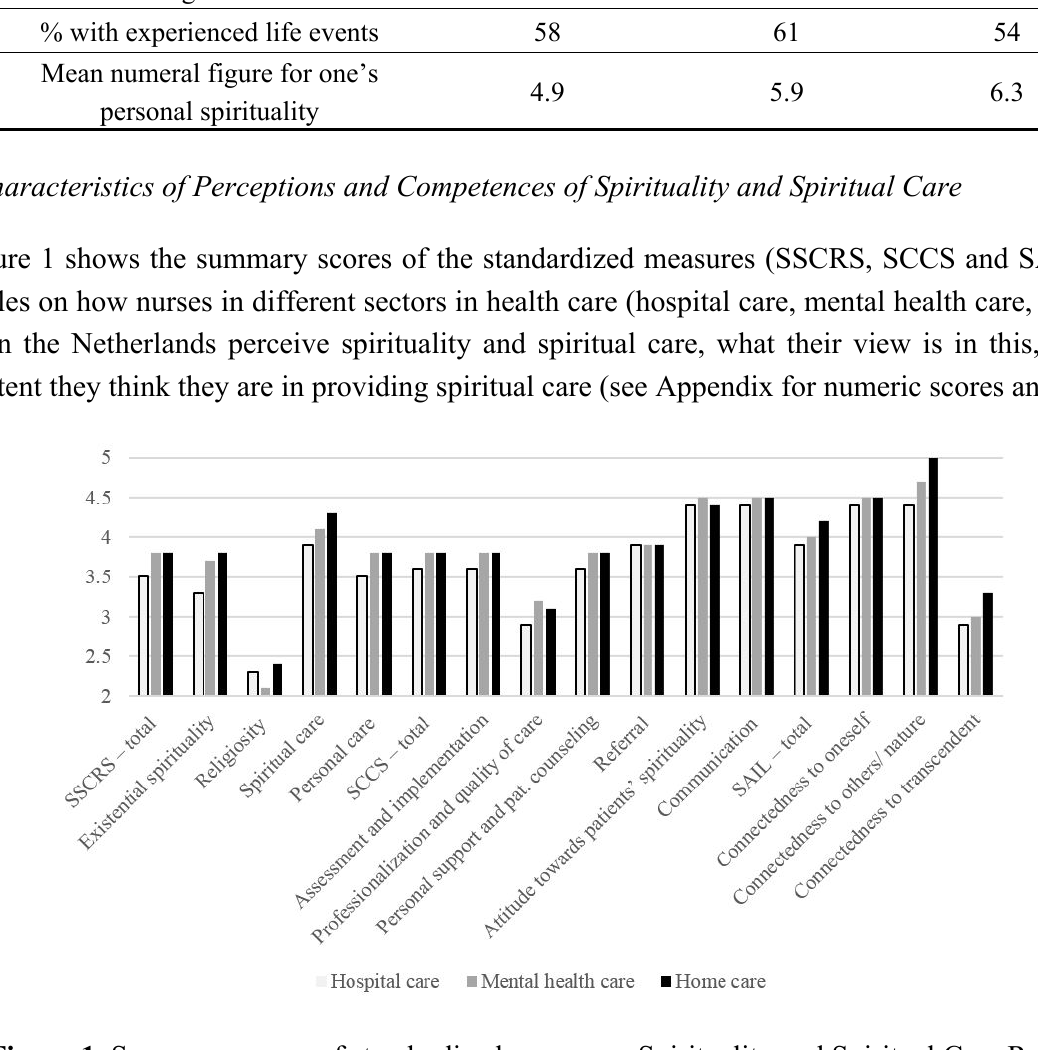
Figure 1. Summary scores of standardized measures: Spirituality and Spiritual Care Rating Scale (SSCRS), Spiritual Care Competence Scale (SCCS) and Spiritual Attitude and Involvement List (SAIL) with subscales per health care